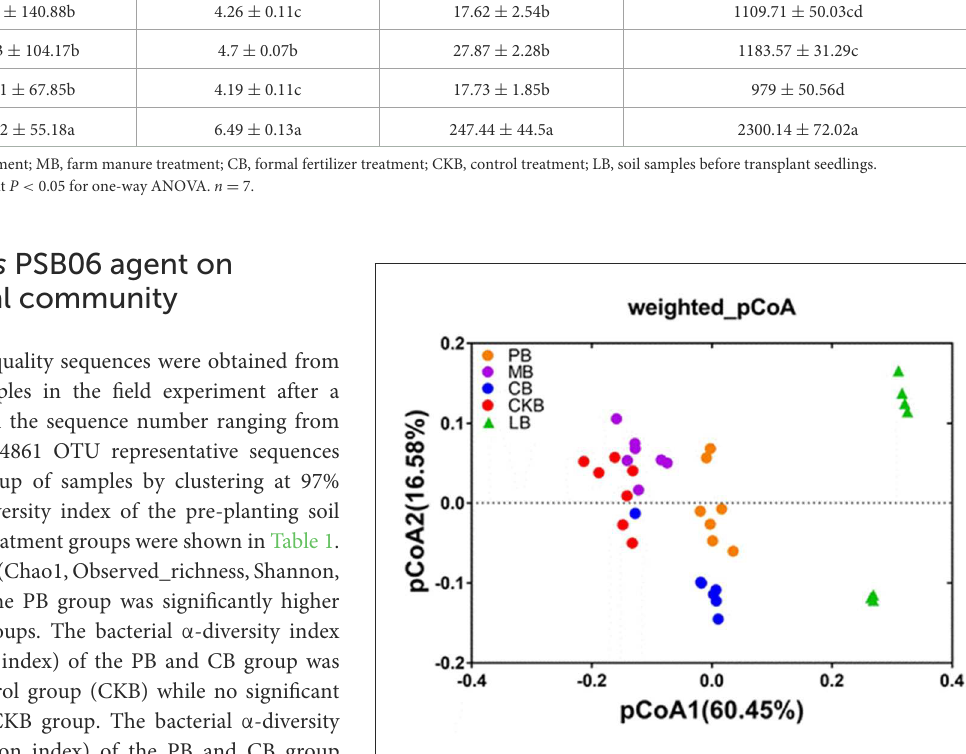
FIGURE3 Principal coordinate analysis (PCoA) of bacterial communities among different treatments. PB, R. palustris PSB06 root-irrigation treatment; MB, farm manure treatment; CB, formal fertilizer treatment; CKB, control treatment; LB, soil samples before planting, n =